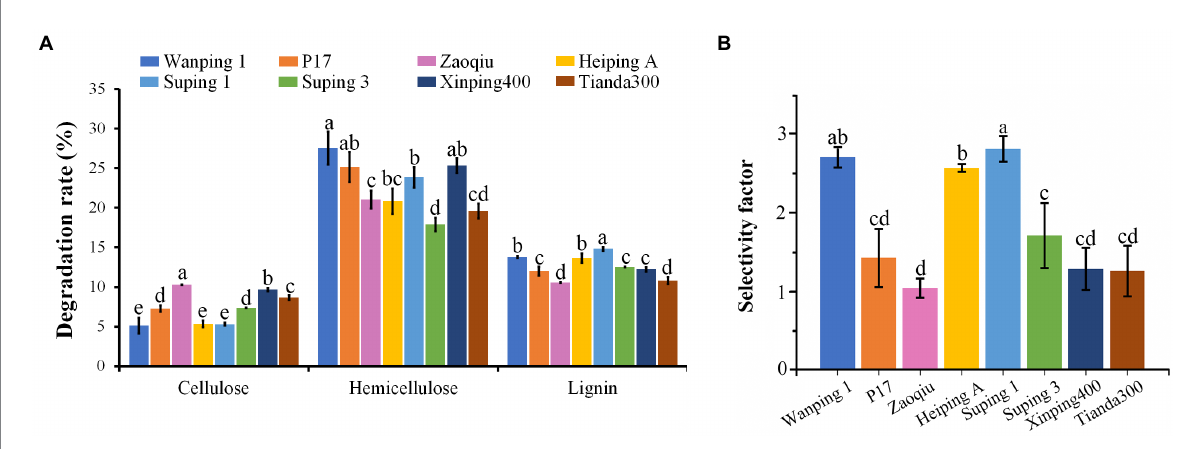
FIGURE 1 Degradation rates of three major components (cellulose, hemicellulose, and lignin) of cotton stalks using eight P. ostreatus strains and their selectivity factors. (A) Degradation rates of cotton stalks. (B) Selectivity factors of eight P. ostreatus strains. The different letters in the same pillars indicate significant differences according to the LSD at p ≤ 0.05 levels.